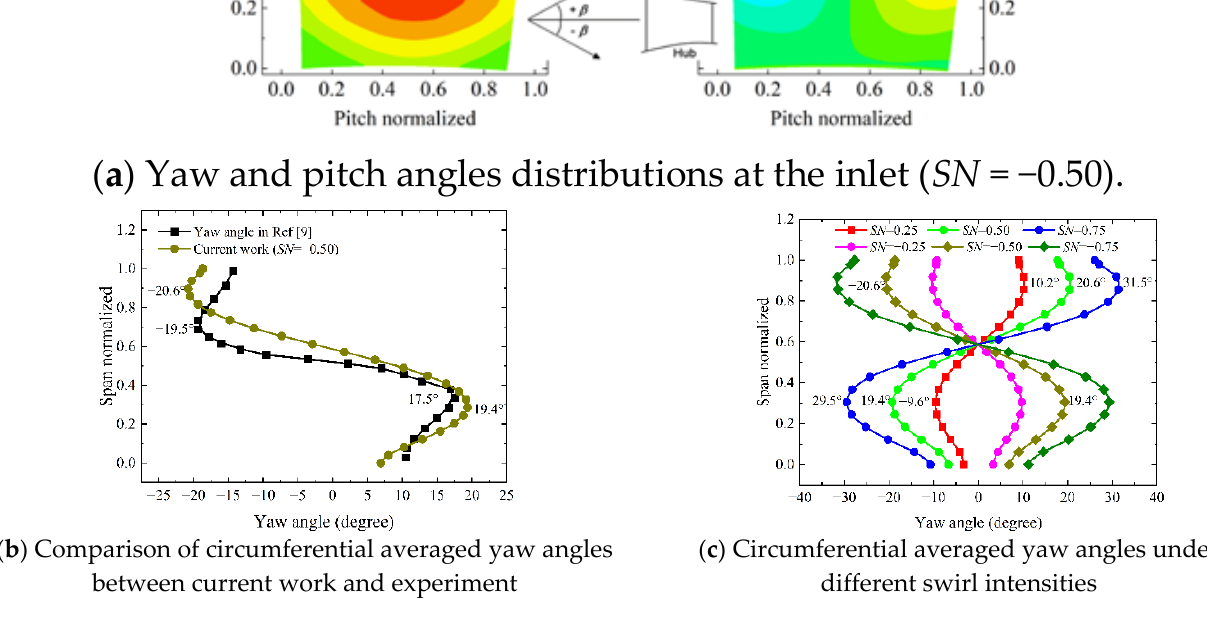
Figure 4. Swirl profiles at the inlet.